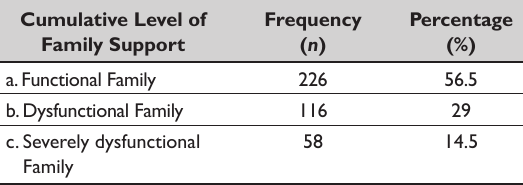
Table 5: Cumulative levels of family support